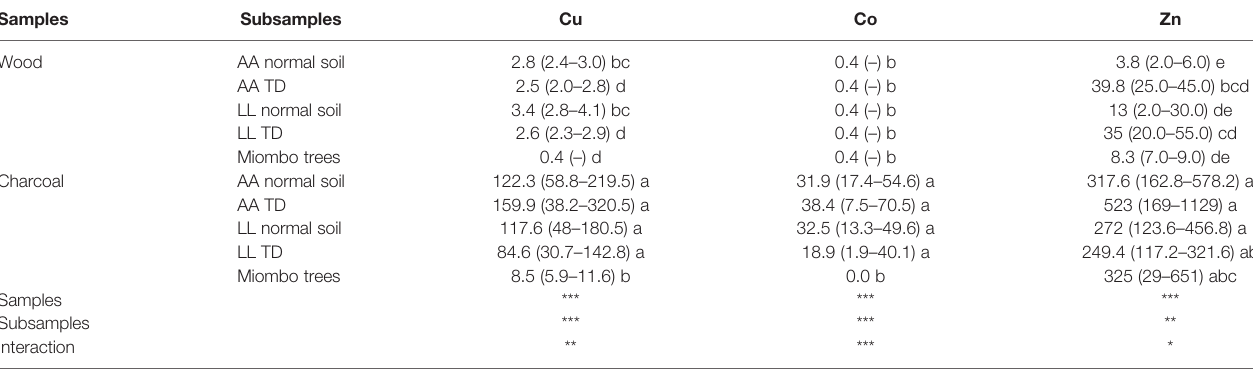
TABLE 8 | Trace metal concentration in wood and charcoals from contaminated and normal sites (mg kg − 1 dry weight; n = 4) . AA, A. auriculiformis ; LL, L. leucocephala . Samples Subsamples Cu Co Zn